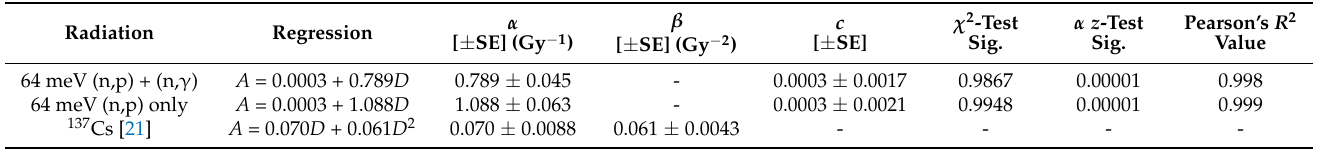
Table 3. DCA linear dose response regression and R 2 values for 64 meV thermal neutrons and 137 Cs photons.